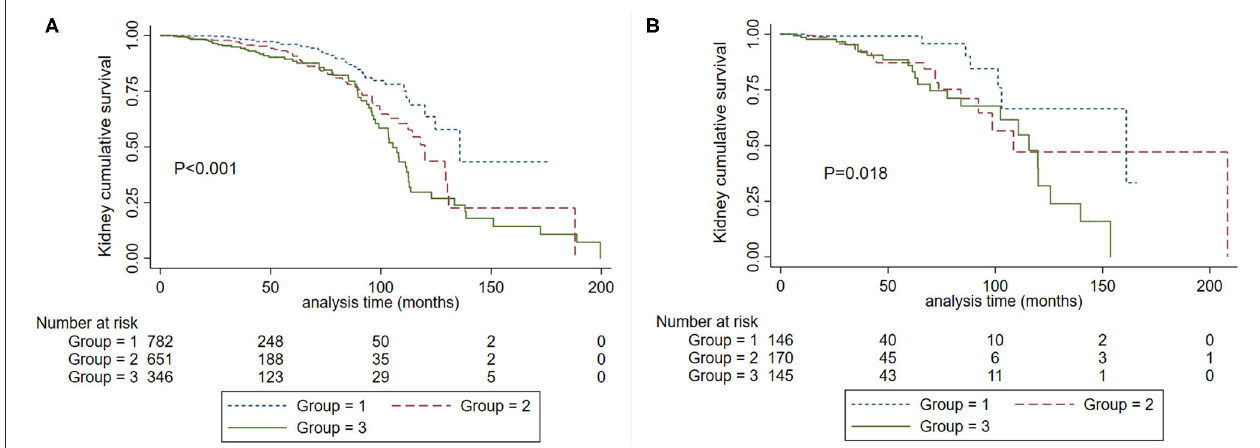
FIGURE 6 | Kaplan-Meier renal survival curves according to the treatment of antihypertension in patients with SBP < 120mm Hg. Group 1. Without antihypertension treatment. Group 2, with antihypertension treatment.